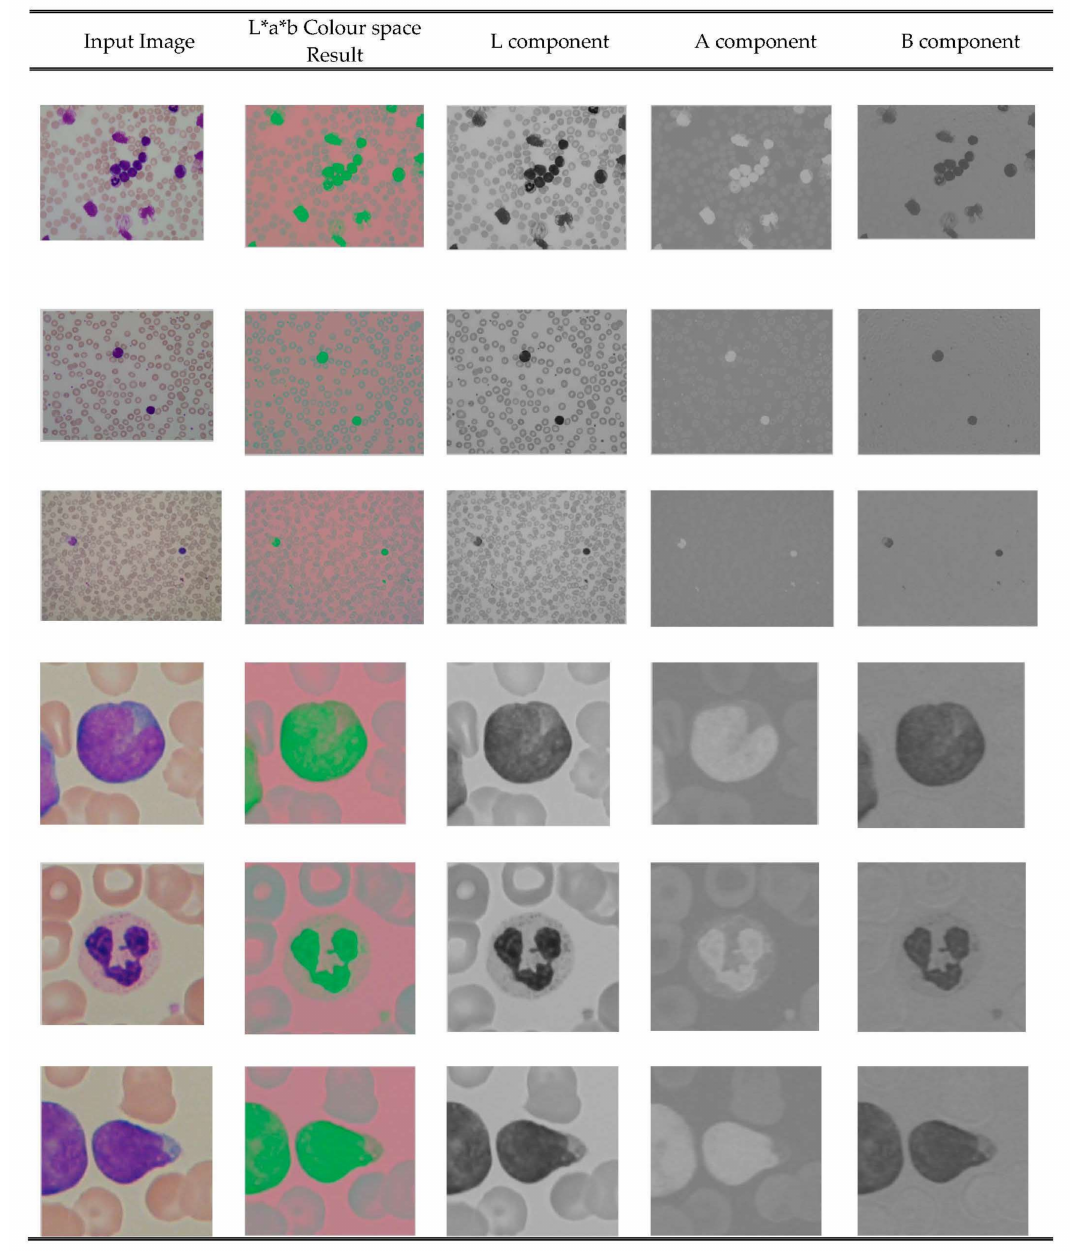
Figure 2. L*A*B colour conversion